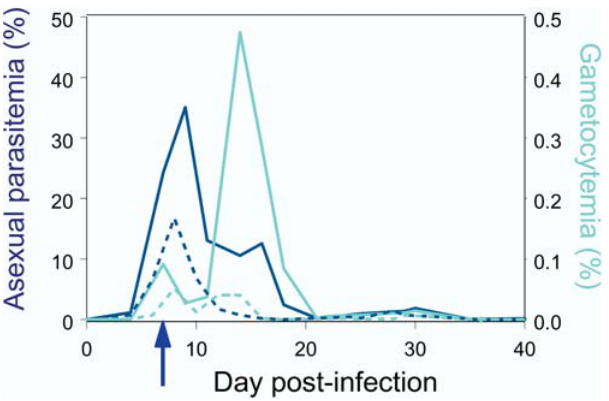
Figure 2. Effect of Immunization on Asexual Parasitemia and Game- tocytemia Each curve represents the mean asexual parasitemia (dark blue) and gametocytemia (light blue) over all parasite lines (ancestral and selected) in naı¨ve (solid lines; n = 47) and immunized mice (broken lines; n = 50) during the pretransmission evaluation phase. Immunization reduced asexual parasitemia and gametocytemia throughout the infection ( p , 0.001 based on the log 10 daily average taken over all days). The arrow indicates the day of transfer during the selection phase of the experiment.